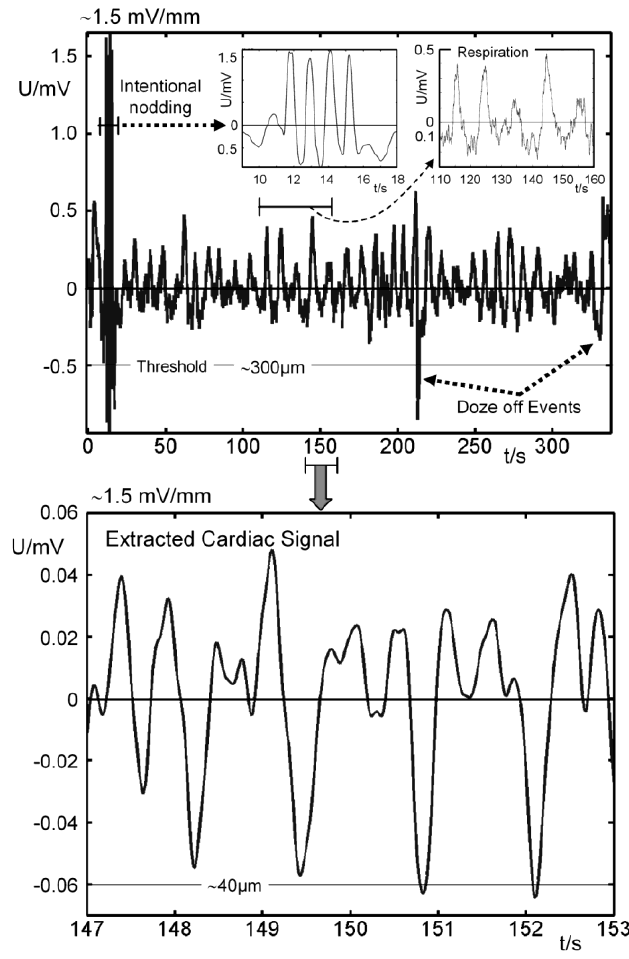
Figure 4. Top: motion reconstructed from a measured time interval of 350 s. The left inset displays the four nodding events (~1 mm amplitude, episode [t = 10 s,…,t = 18 s]) to localize the surface of the head. Respiratory displacements are clearly visible (right inset, episode [t = 110 s,…, t = 160 s]) and spontaneous twitches are highlighted. Bottom: selected filtered time interval from the upper time course, showing the cardiac induced